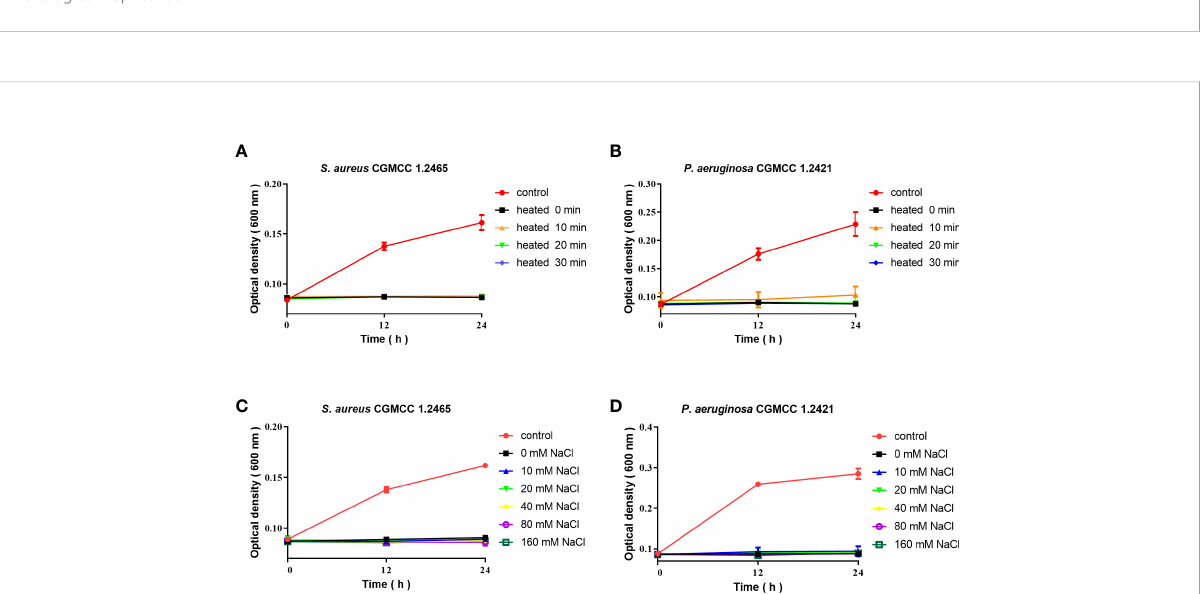
FIGURE 5 Thermal stability and cationic ion activity of Spgillcin 177 – 189 against S. aureus and P. aeruginosa . (A) Thermal stability of Spgillcin 177 – 189 against S. aureus. (B) Thermal stability of Spgillcin 177 – 189 against P. aeruginosa . (C) Antimicrobial activity of Spgillcin 177 – 189 against S. aureus at different concentrations of NaCl salt solutions. (D) Antimicrobial activity of Spgillcin 177 – 189 against P. aeruginosa at different concentrations of NaCl salt solutions.